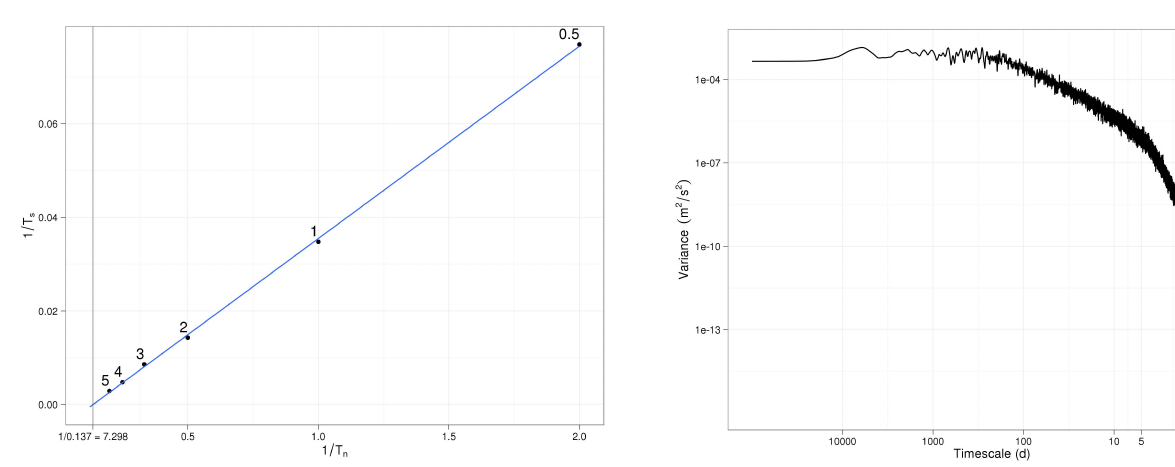
Fig. 8. Power spectrum of the ( 0 , 1 ) spherical harmonical